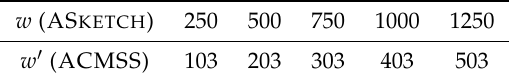
Table 1. Number of columns